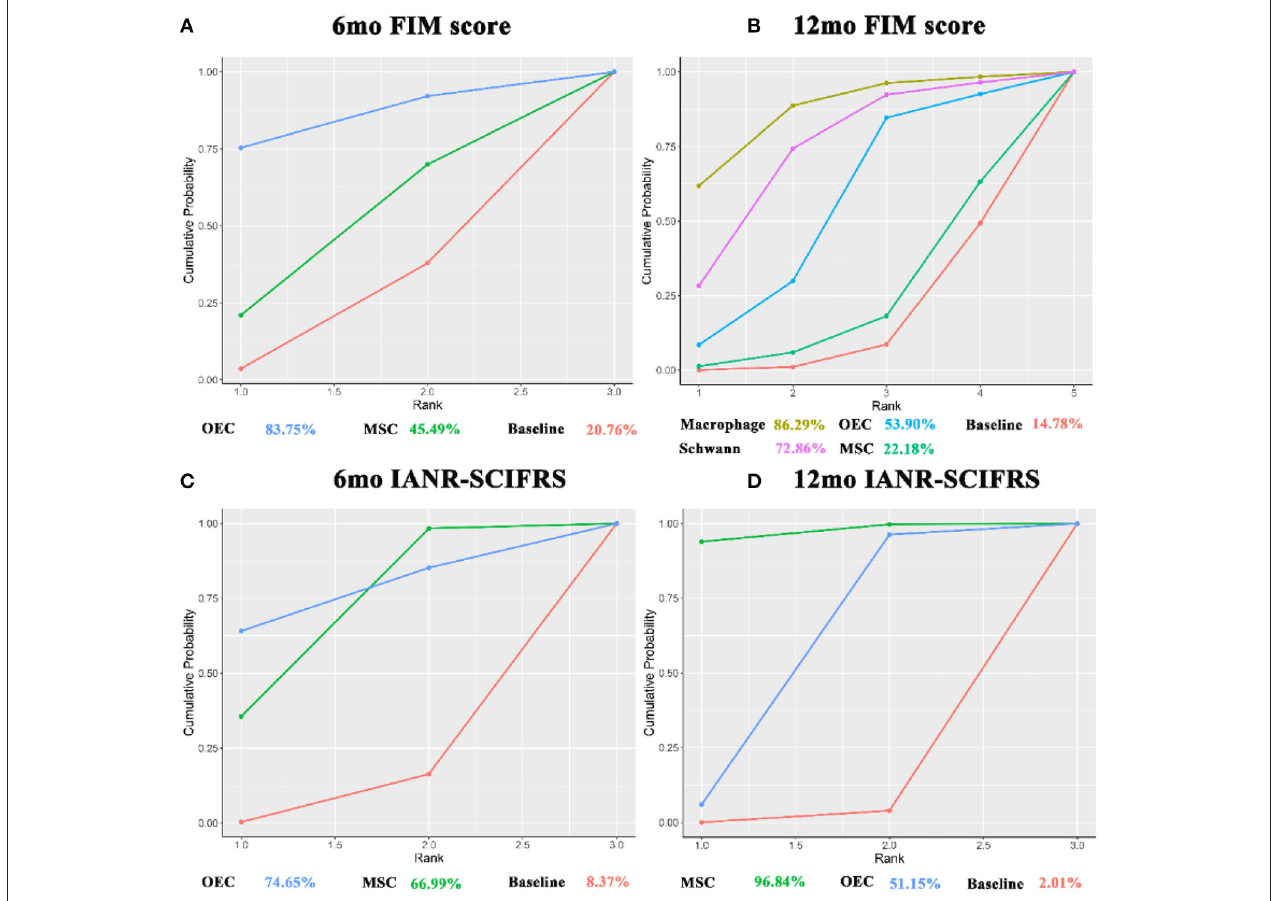
FIGURE 7 | SUCRA for FIM score and IANR-SCIFRS. (A) SUCRA for 6mo FIM score; (B) SUCRA for 12mo FIM score; (C) SUCRA for 6mo IANR-SCIFRS; (D) SUCRA for 12mo IANR-SCIFRS. The x-axis represents the ranking and the y-axis represents the cumulative probability. The cumulative ranking and cumulative probability are constructed as a curve. The larger the area under the curve, the greater the benefit of the intervention. FIM, Functional independence measure; IANR-SCIFRS, International Association of Neurorestoratology Spinal Cord Injury Functional Rating Scale; mo, month; SUCRA, the surface under the cumulative ranking; MSC, mesenchymal stem cell; NSC, neural stem cell/neural progenitor cell; OEC, olfactory ensheathing